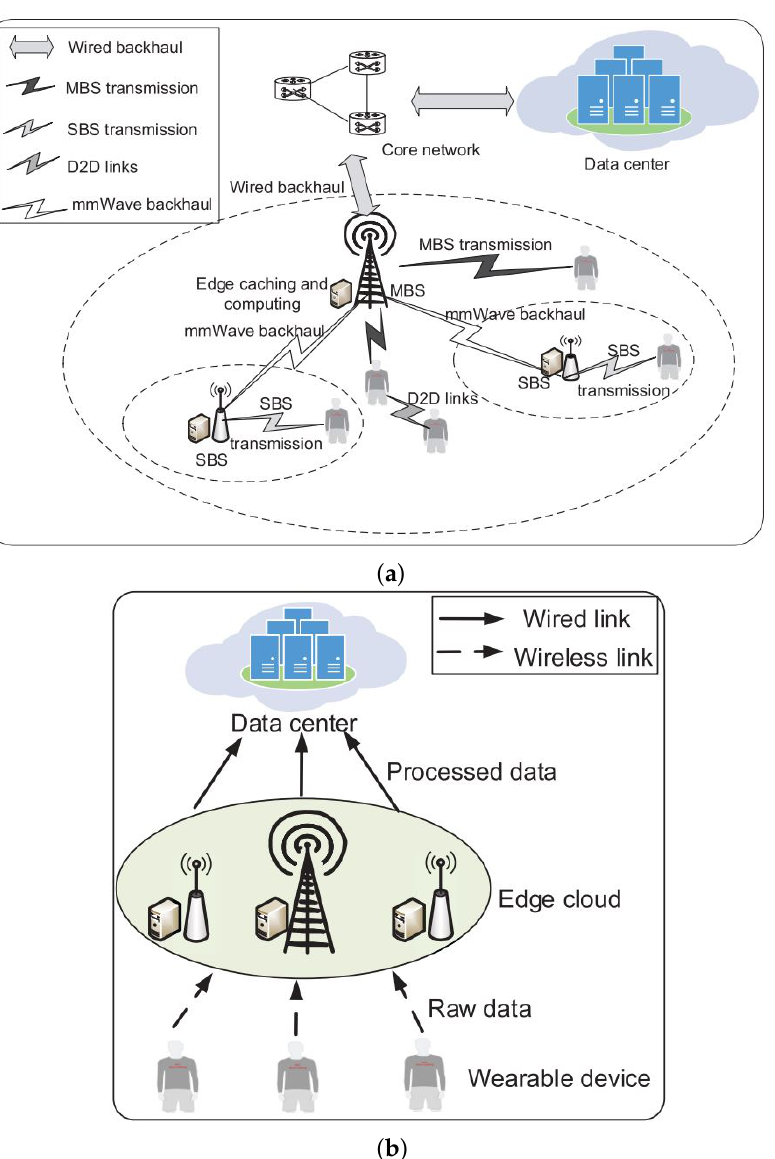
Figure 4. ( a ) The 5G ultra-dense cellular network in the wearable network macro-cell base station (MBS), small cell base station (SBS), device-to-device (D2D) (top); and ( b ) illustration of edge cloud and the data center (bottom) [36]. Reprinted/adapted with permission from Ref. [36]. Copyright 2022,